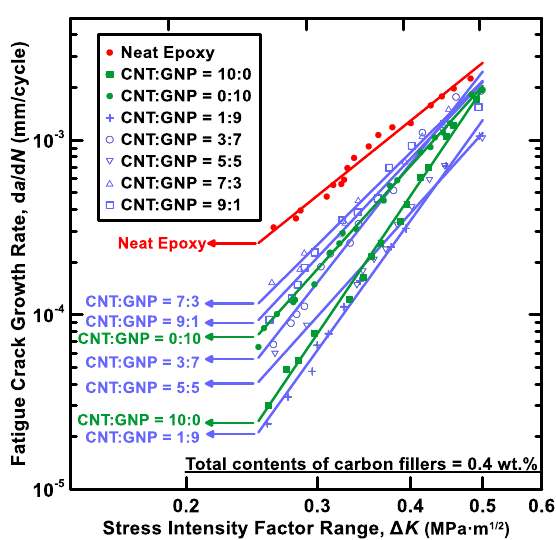
Figure 13. Relationship between the crack propagation rates da/d N and the stress intensity factor ranges Δ K for the studied nanocomposites with different filler ratios.